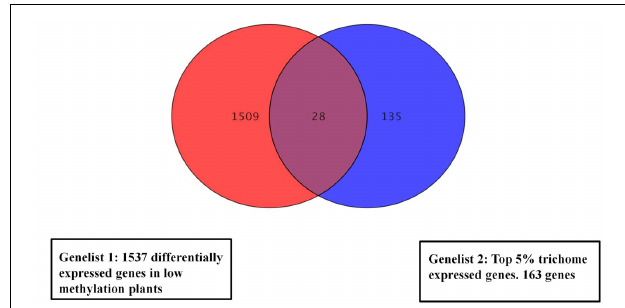
FIGURE 4 |Venn diagram showing overlapping expression changes of genes between low methylation plants and a trichome specific set. For the overlap search all genes with significant change were used from the low methylation versus wild type dataset (1537 genes).The central region corresponds to genes with changed expression in both trichomes and low methylation plants.The gene list is inTable S5 in Supplementary